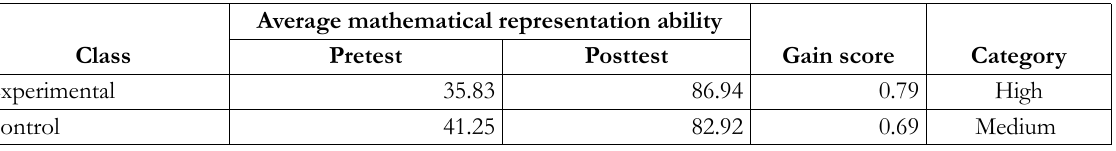
Table 11. Result of mathematical representation ability test